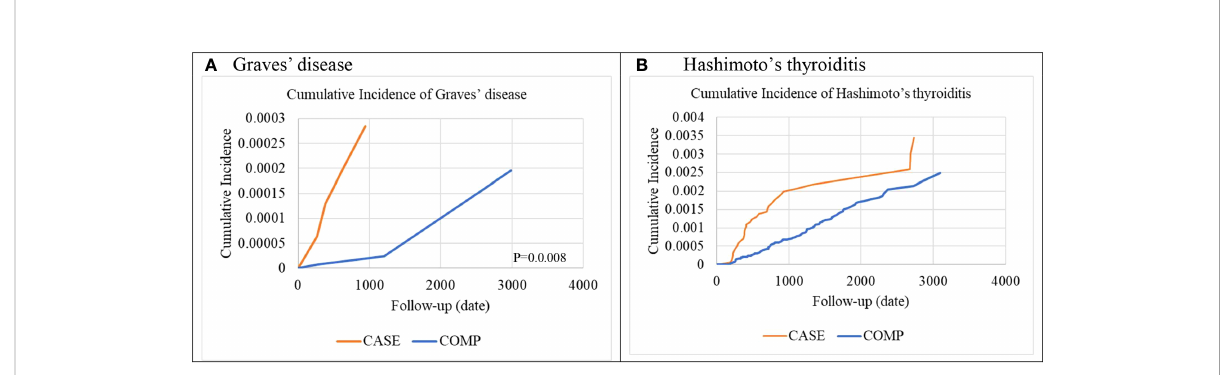
FIGURE 2 Cumulative incidence of organ-speci fi c autoimmune diseases (A) Graves ’ disease (B) Hashimoto ’ s thyroiditis.